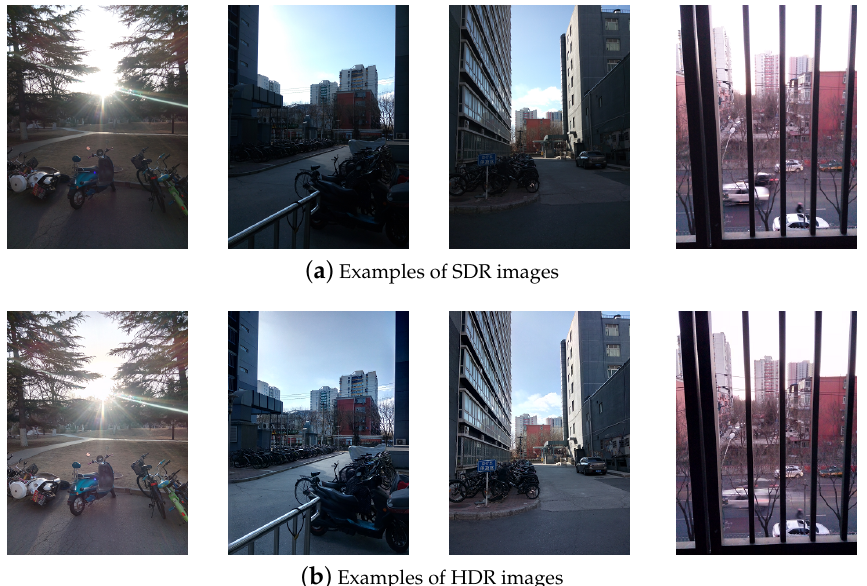
Figure 1. Examples of ( a ) Standard Dynamic Range (SDR) and ( b ) High Dynamic Range (HDR)